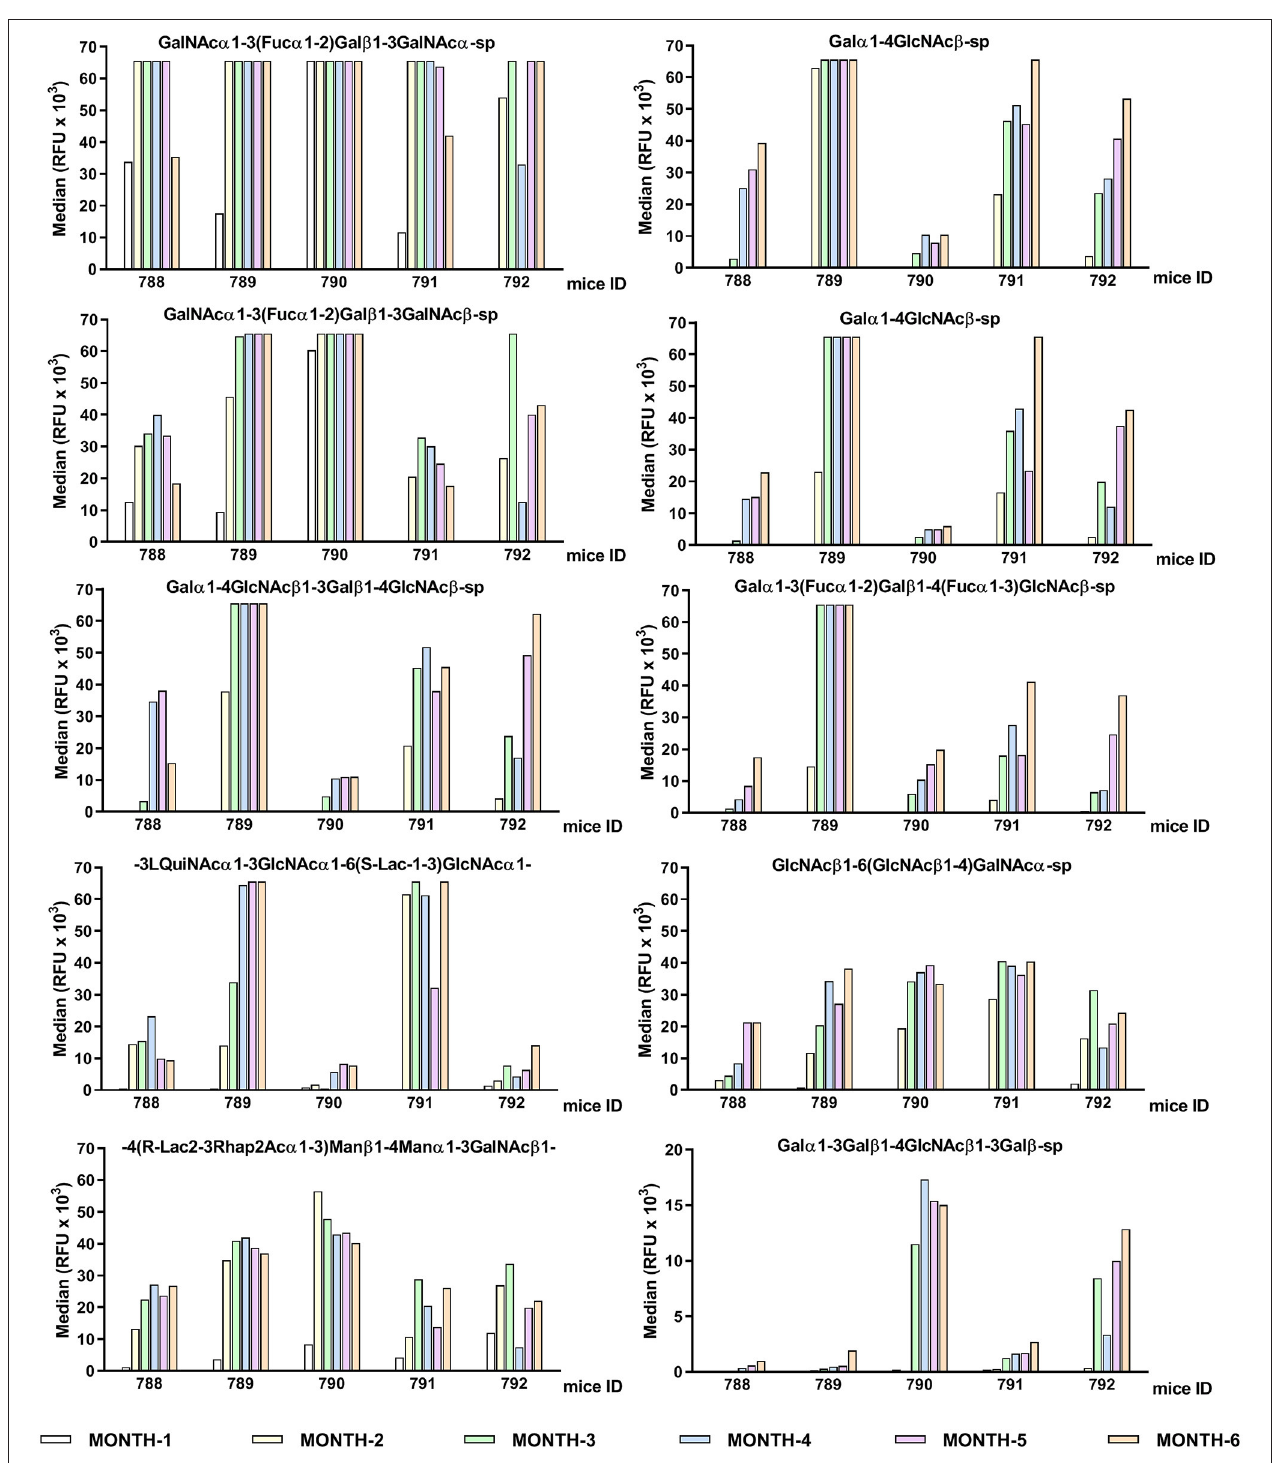
FIGURE 3 | Individual differences in the conserved top-rank repertoire of circulating anti-glycan antibodies of GalT-KO mice during lifetime ( n = 5). The first ten anti-glycan antibodies showing the strongest binding signals are represented. GalT-KO mice serum (1:15) was incubated with chips printed with 682 different glycans (6 replicates). Chips were scanned using a ScanArray GX Plus reader and data were analyzed with the ScanArray Express Microarray Analysis System (PerkinElmer). The binding results for IgM + IgG + IgA are expressed in RFU as the median.